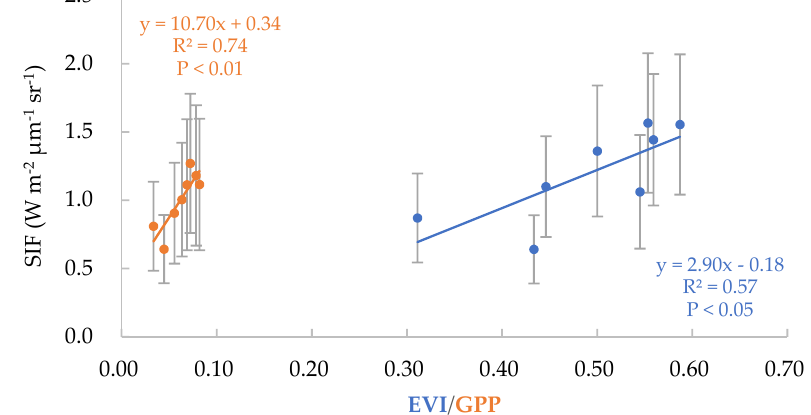
Figure 3. Scatter plots of SIF–EVI and SIF–GPP in the study region at a 16 ‐ day temporal scale. The blue color indicates SIF–EVI, and the orange color indicates SIF–GPP.